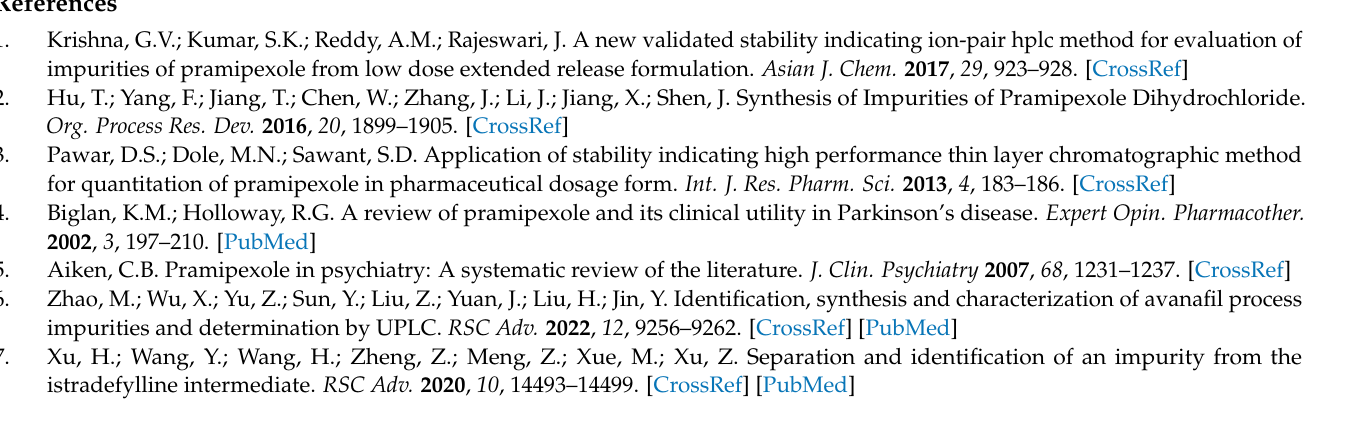
pramipexole corresponding to injection of reaction mixture of HPMC and pramipexole in presence of formaldehyde; temperature: 120 ◦ C; time: 2 h; Table S1: Unit composition of pramipexole dihydrochloride extended-release